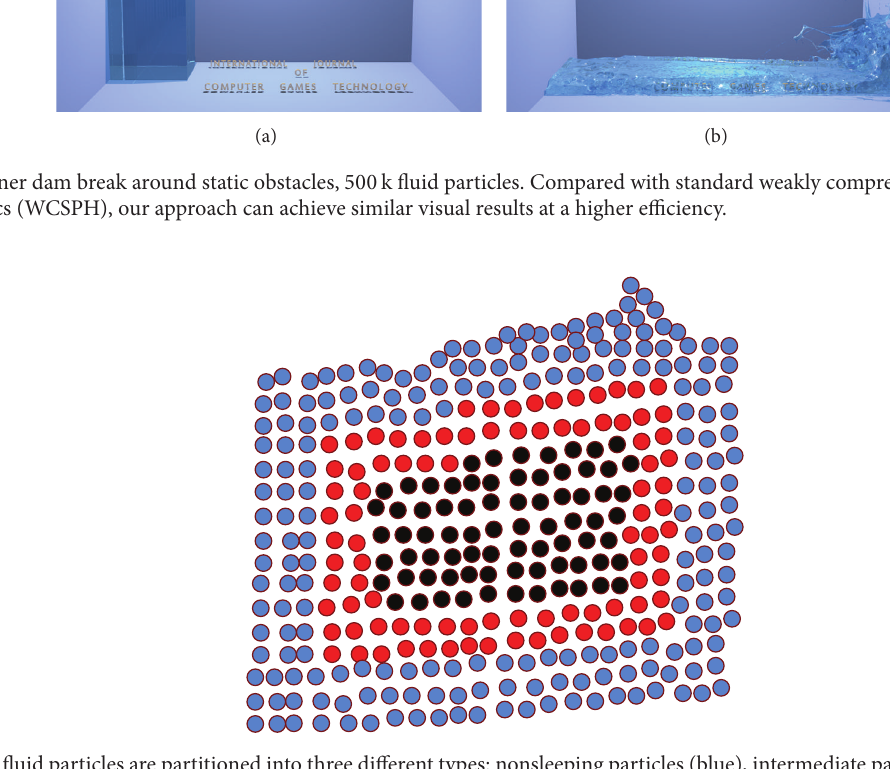
Figure 2: The fluid particles are partitioned into three different types: nonsleeping particles (blue), intermediate particles (red), and sleeping particles (black). The update of physical properties of sleeping particles can be saved in our method, leading to a performance boost without affecting visual fidelity.